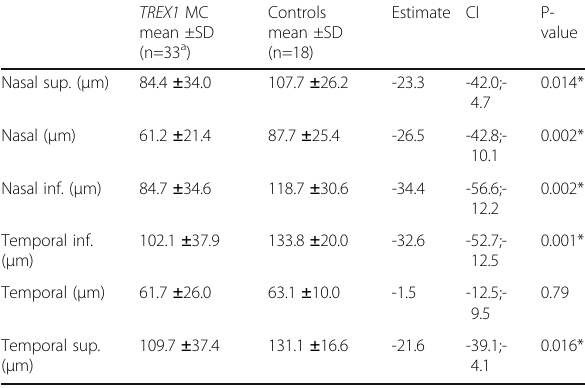
Table 1 (abstract P75). Thickness of peripapillary sectors of the pRNFL in TREX1 mutation carriers and